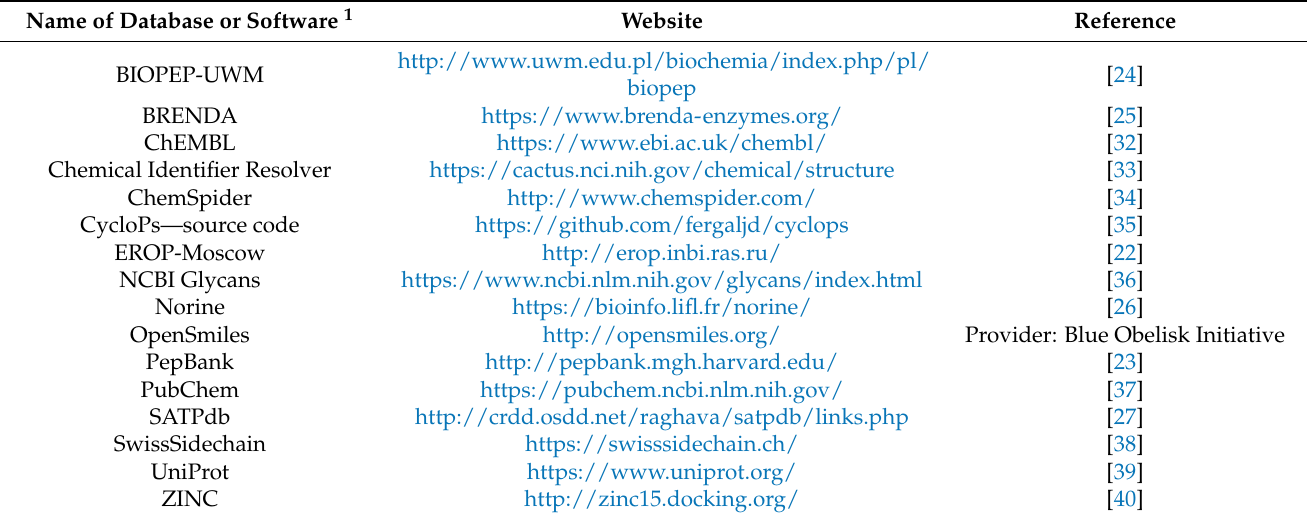
Table 1. Bioinformatic and cheminformatic tools cited in this